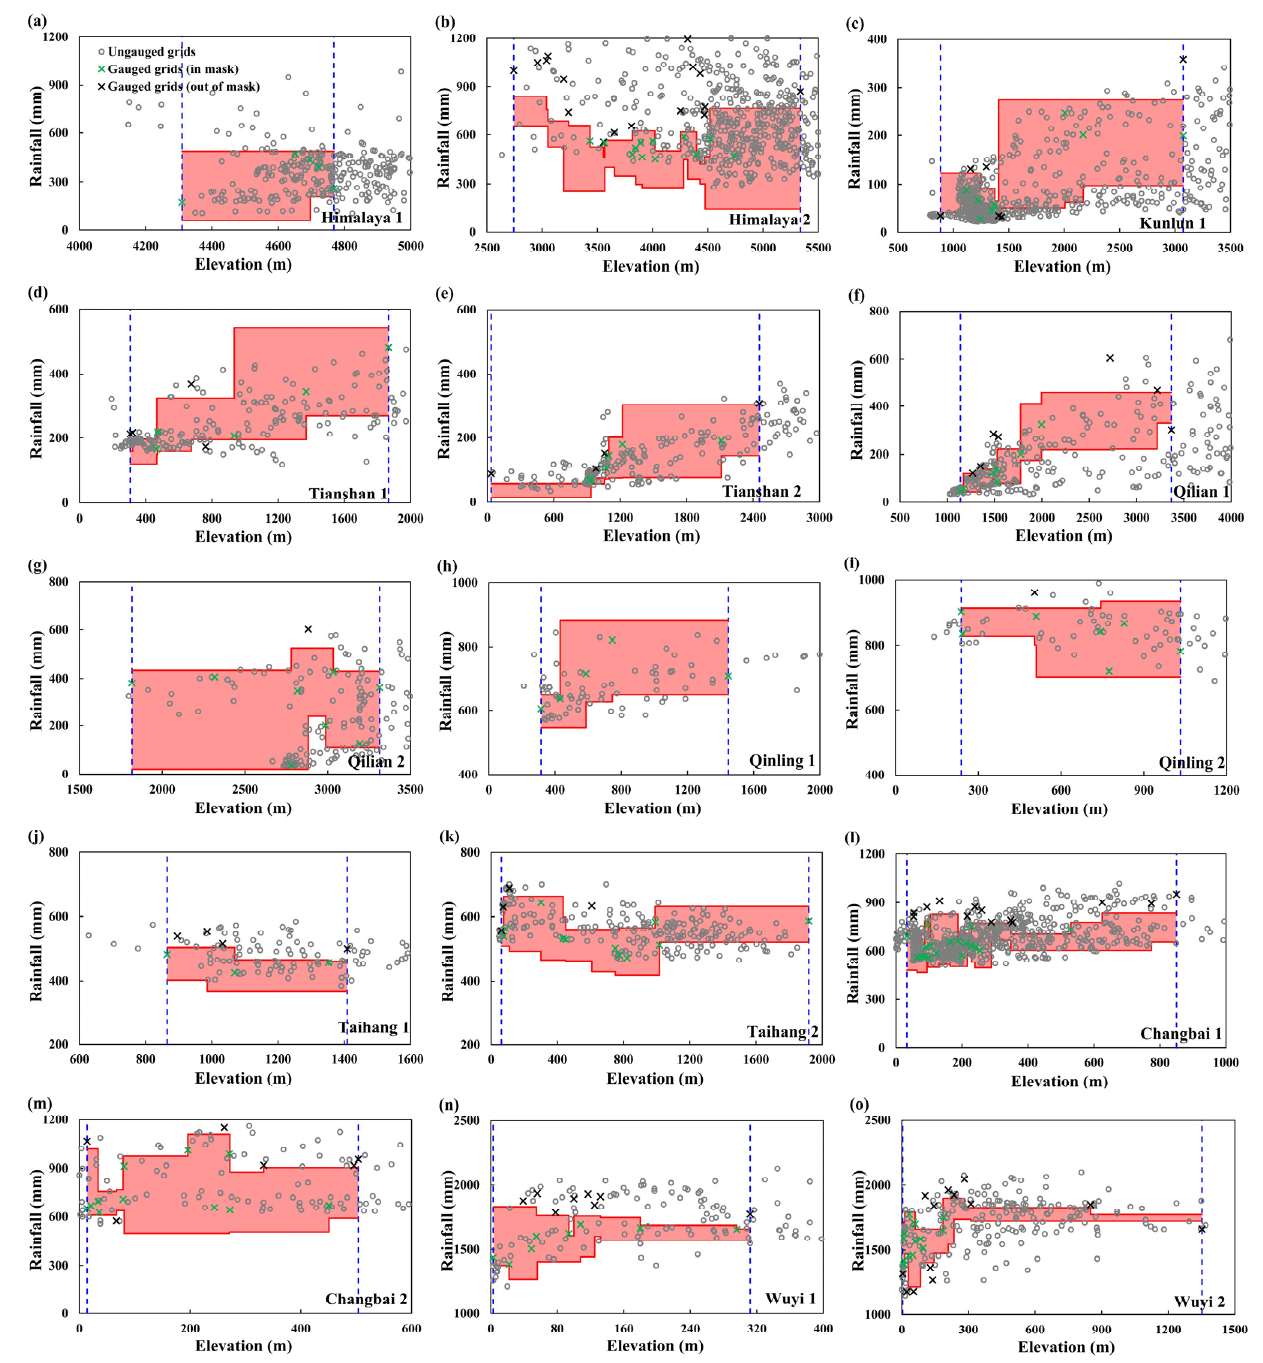
Figure 4. The mean annual (2001–2012) rainfall-elevation mask and rainfall filter (the pink space, l = 3). The green/black forks stand for TMPA rainfall grid cells with gauges located in/out of the masks. The grey circles are the cells without gauges. Kunlun has only one mask because of lacking of enough gauges on another hillside. ( a , b ) Himalaya, ( c ) Kunlun, ( d , e ) Tianshan, ( f , g ) Qilian, ( h , i ) Qinling, ( j , k ) Taihang, ( l , m ) Changbai, ( n , o )